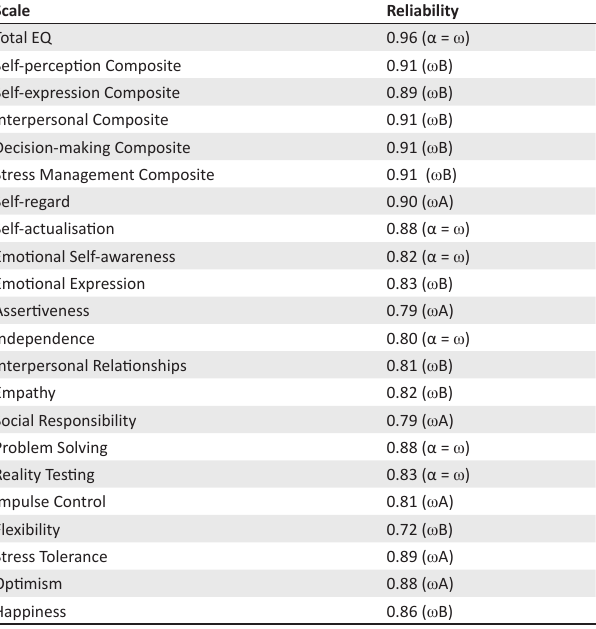
TABLE 3: Internal consistency reliability estimates for the Emotional Quotient Inventory 2.0